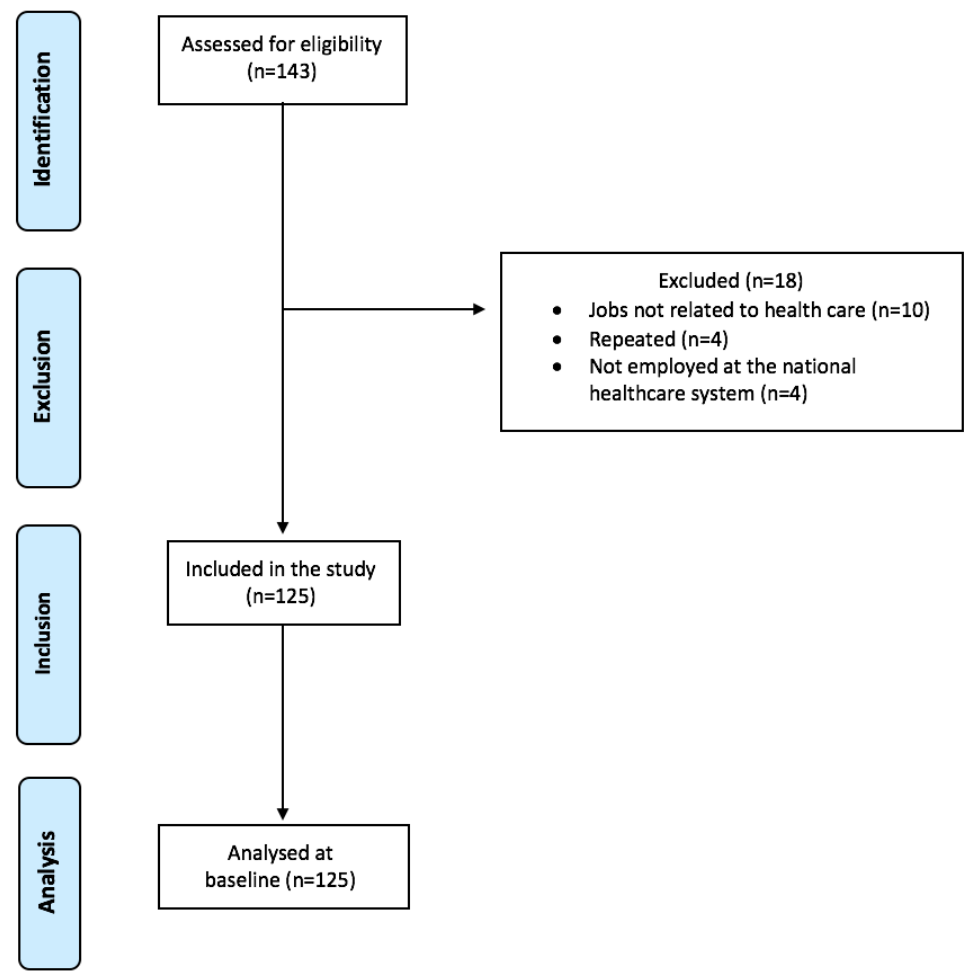
Figure 1. Flowchart of the participant selection process in accordance with Strengthening the Reporting of Observational Studies in Epidemiology (STROBE).